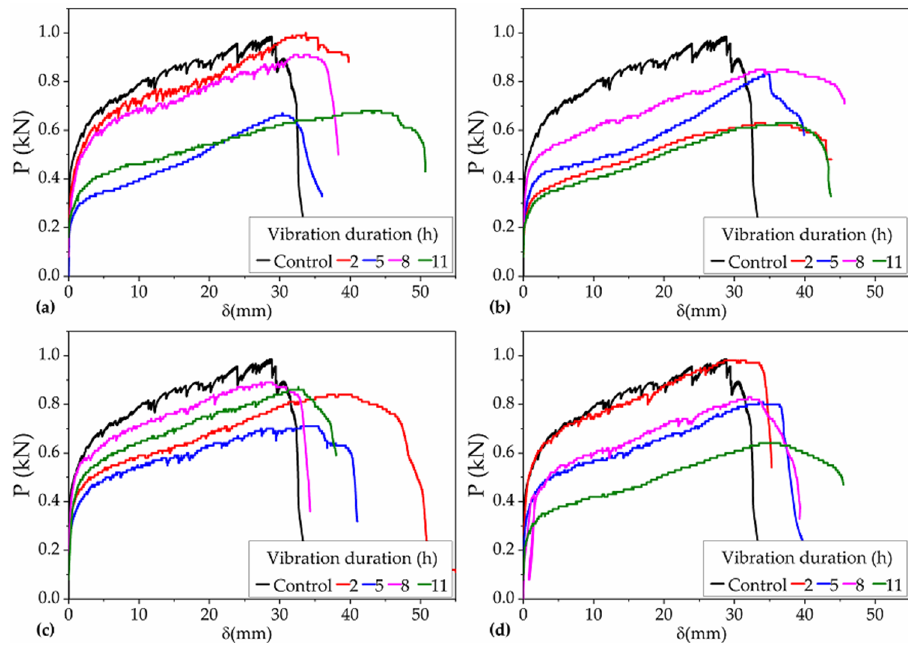
Figure 7. P– δ curves of all the 16 groups of specimens under the operating conditions for Var. 2 with frequencies of ( a ) 2 Hz, ( b ) 3 Hz, ( c ) 4 Hz, and ( d ) 5 Hz and that of the control group.